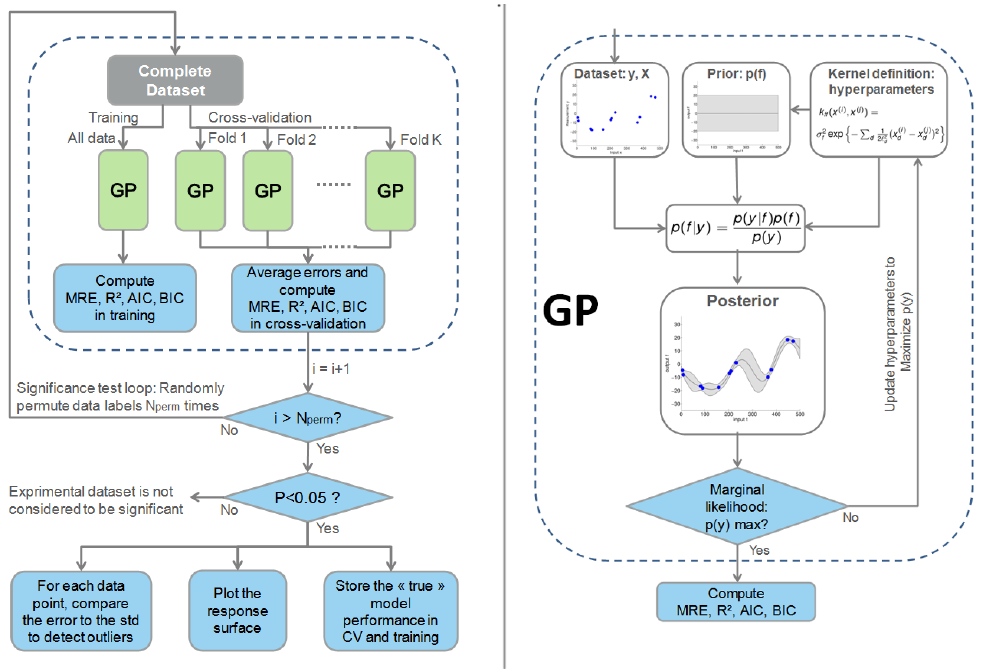
Figure 1. Schematic view of the